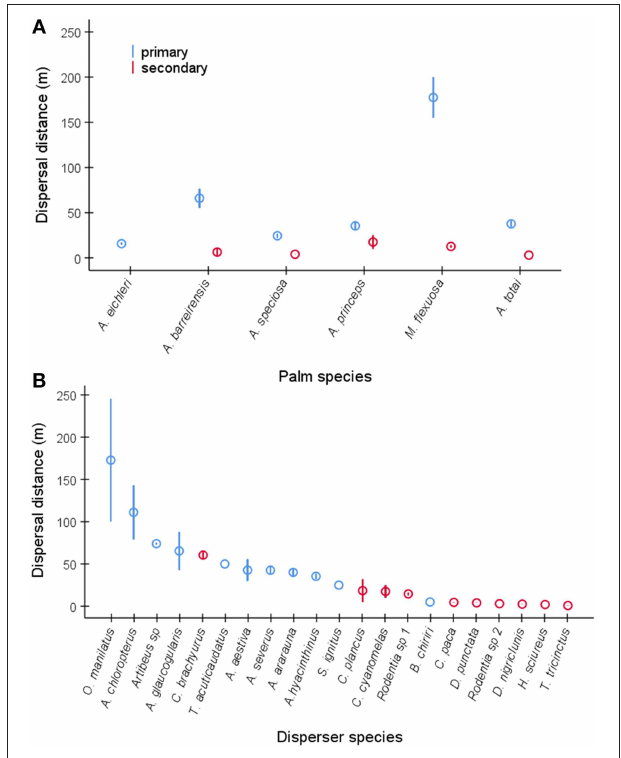
FIGURE 6 | Mean ± SE dispersal distances (in m) for (A) primary and secondary dispersions of seeds of each palm species, pooling disperser species, and for (B) dispersions conducted by each primary and secondary disperser species, pooling palm species. The complete scientific name of each disperser species is shown in Table S2